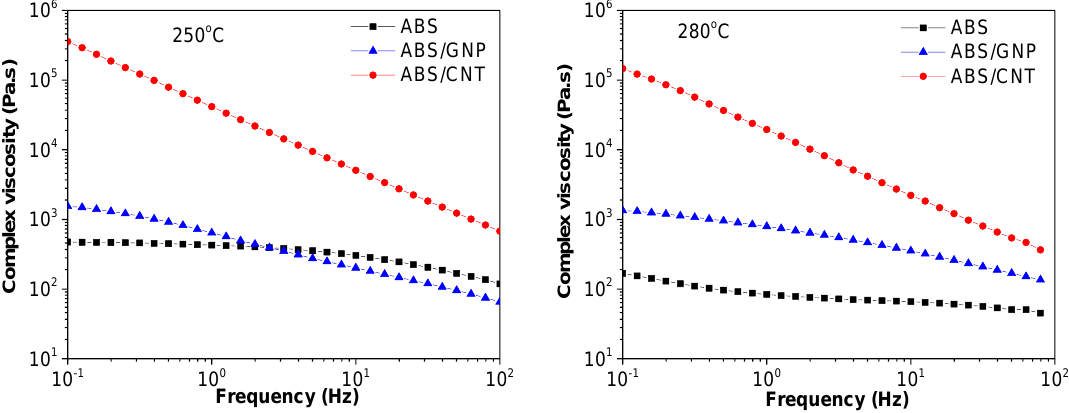
Figure 4. Complex viscosity as a function of frequency at temperature of 250 and 280 ◦ C;